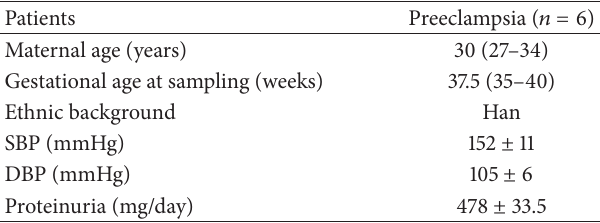
Table 1: Clinical data of patients with preeclampsia